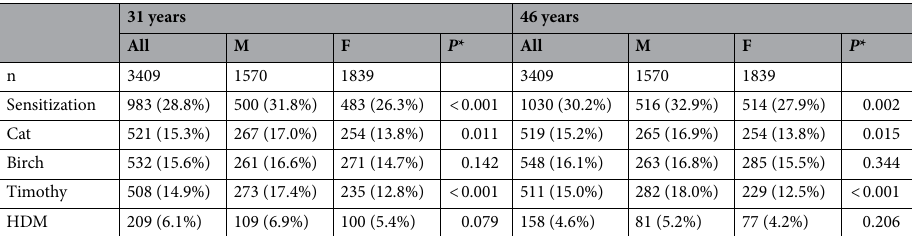
Table 5. Prevalence of sensitization at age 31 and 46 in longitudinal sub-population by sex. HDM house dust mite. * P value for difference between